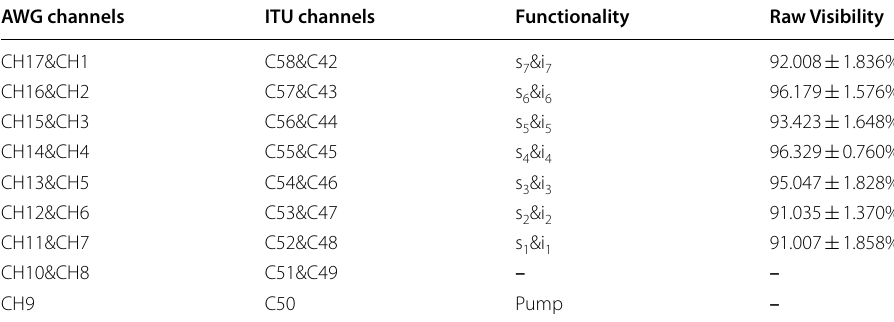
Table 1 Definition and quantum interference visibilities of the AWG channel pairs. “s” and “i” represent “signal” and “idler” photons, respectively. It should be noted that the central three channels (CH8, CH9 and CH10) of the AWG are in the range of the post filter (gray zone in Chip II in Fig. 3(a)). Thus, their visibilities are